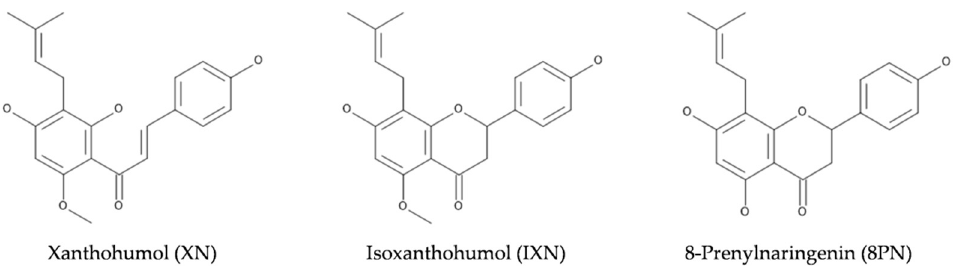
Figure 1. Chemical structures of the selected prenylflavonoids.